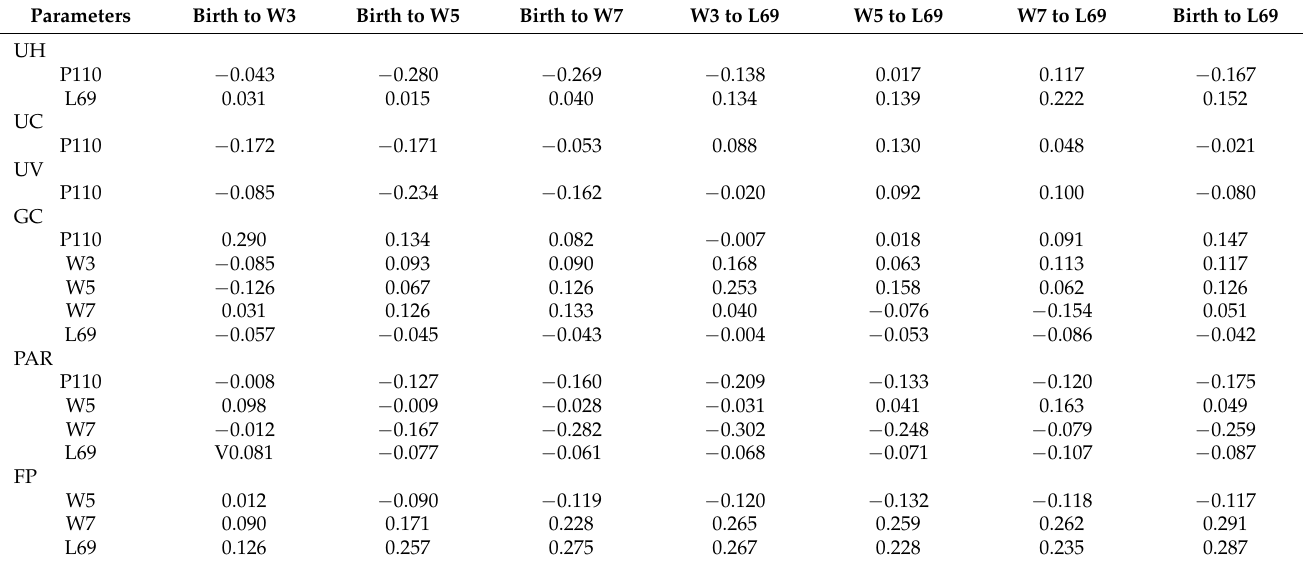
Table 3. Correlation coefficients of residuals of lamb growth from birth to week 3 of lactation (Birth to W3), birth to week 5 of lactation (Birth to W5), birth to week 7 of lactation (Birth to W7), L3 to weaning (W3 to L69), W5 to weaning (W5 to L69), W7 to weaning (W7 to L69), birth to weaning (Birth to L69), the average of both udder half of udder height (UH) in pregnancy (P110) and at weaning (L69), udder circumference and volume at P110, the average of both udder halves of